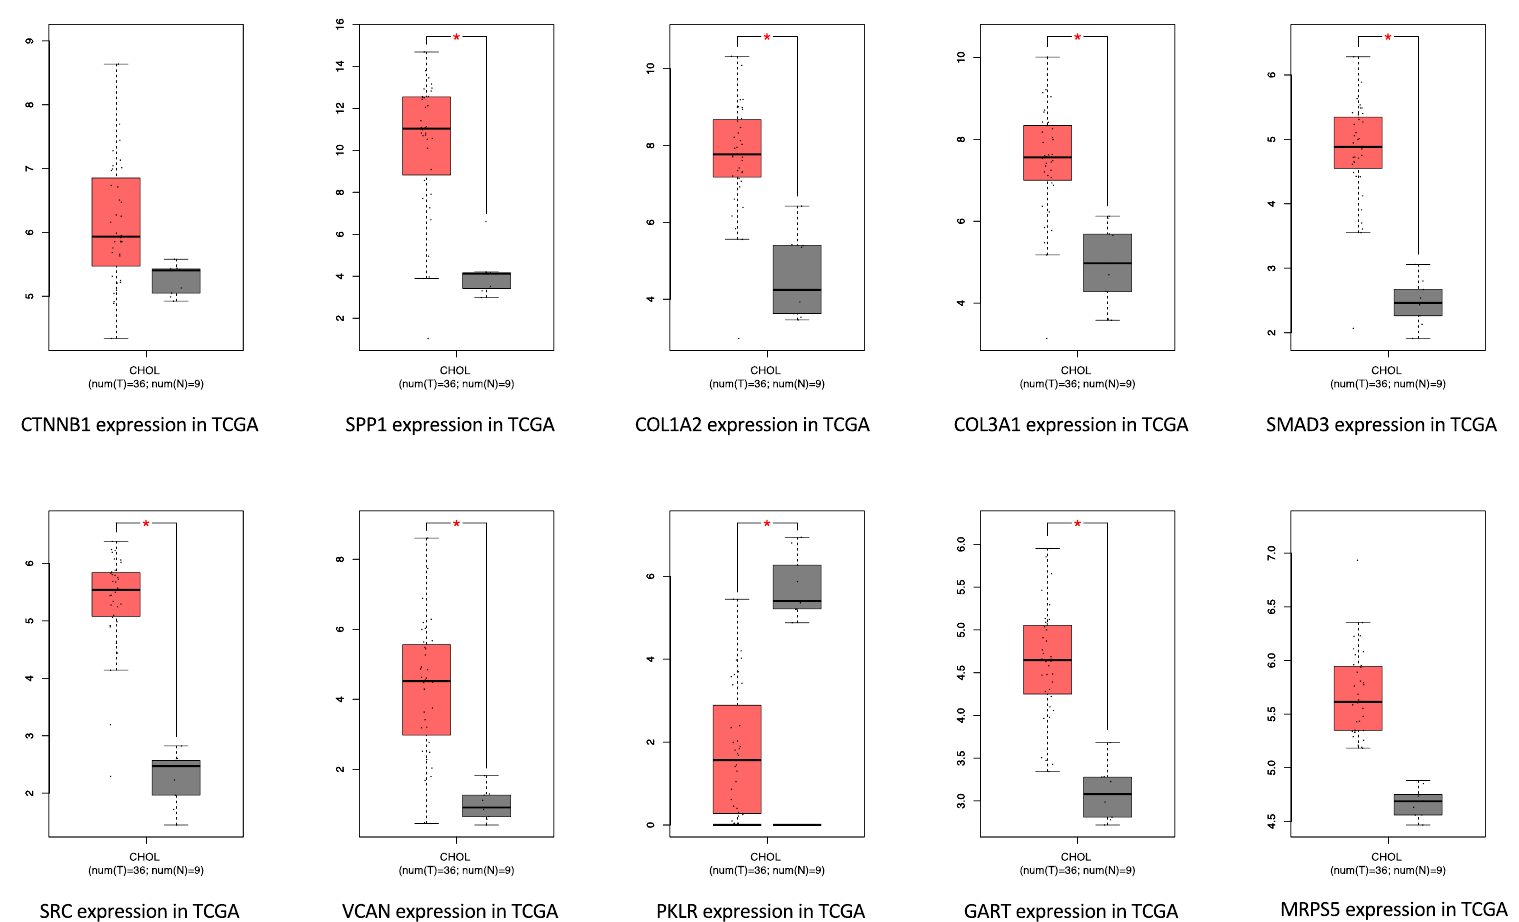
Figure 6. Gene expression level of top hub genes in TCGA-CHOL. Red box: tumor sample; gray box: normal tissue. log2(TPM + 1) scale was used to transform the expression data for plotting.